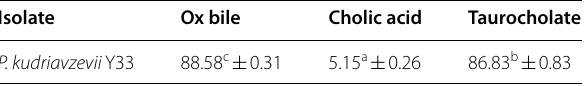
Values represented as mean standard deviation (SD) of triplicate analysis ± a-c Average in the rows with same superscript letter are not significantly (p < 0.05) different as measured by 2 sided Tukey’s post hoc range test between